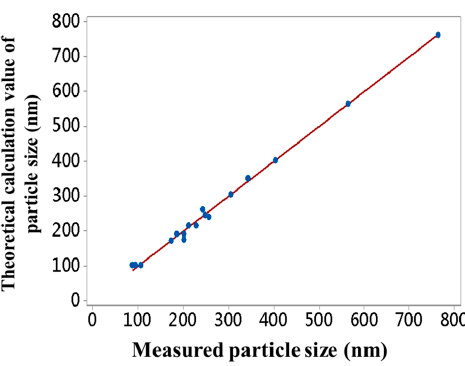
Figure 3. The relationship curve of the predicted values and the measured values of particle sizes.